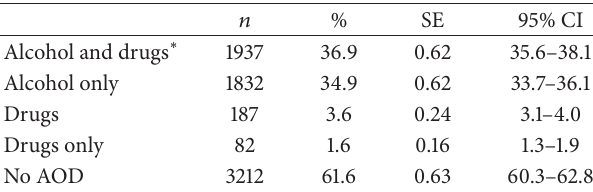
Table 2: Prevalence of self-reported alcohol and other drug use in the screened sample (𝑛 = 5231)